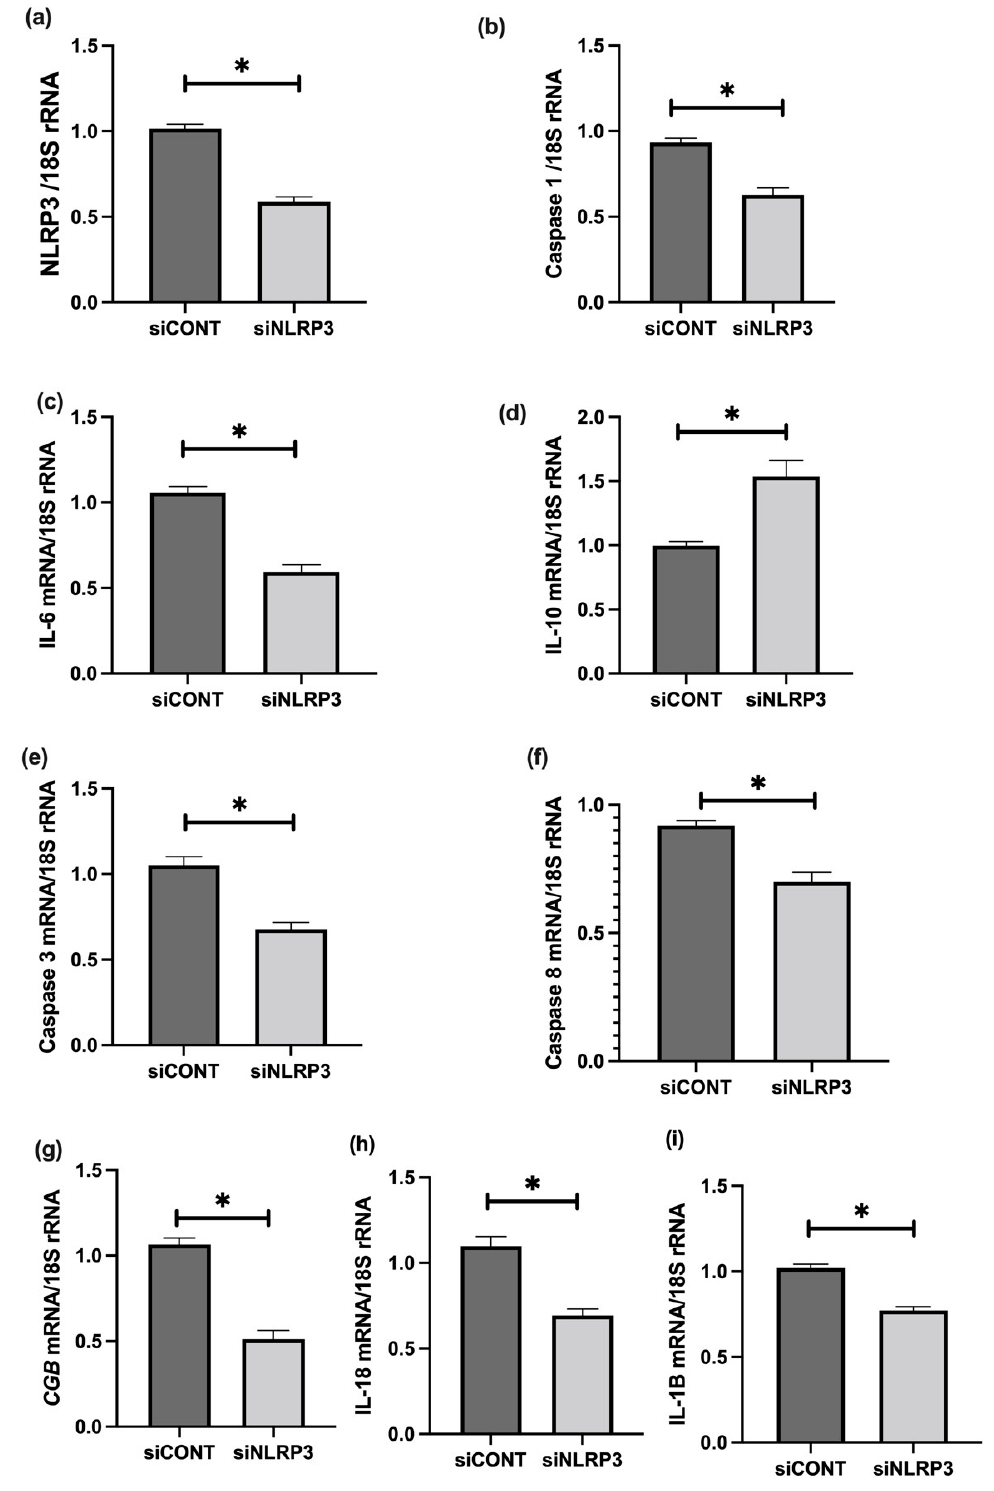
Figure 9. Effect of NLRP3 siRNA inactivation and LPS treatment on mRNA expression of NLRP3, caspase-1, pro- and anti-inflammatory cytokines, trophoblast differentiation, and apoptosis markers in BeWo cells. siNLRP3 treatment significantly decreases LPS-induced BeWo cell expression of ( a ) NLRP3, ( b ) caspase-1, ( c ) IL-6, ( i ) IL-1 β , ( h ) IL-18, ( g ) CGB, and ( e ) caspase-3 and ( f ) Caspase-8 mRNA, but increases ( d ) IL-10 mRNA relative to 18S rRNA , compared to siCONT treated cells. Significant differences are denoted by * p <